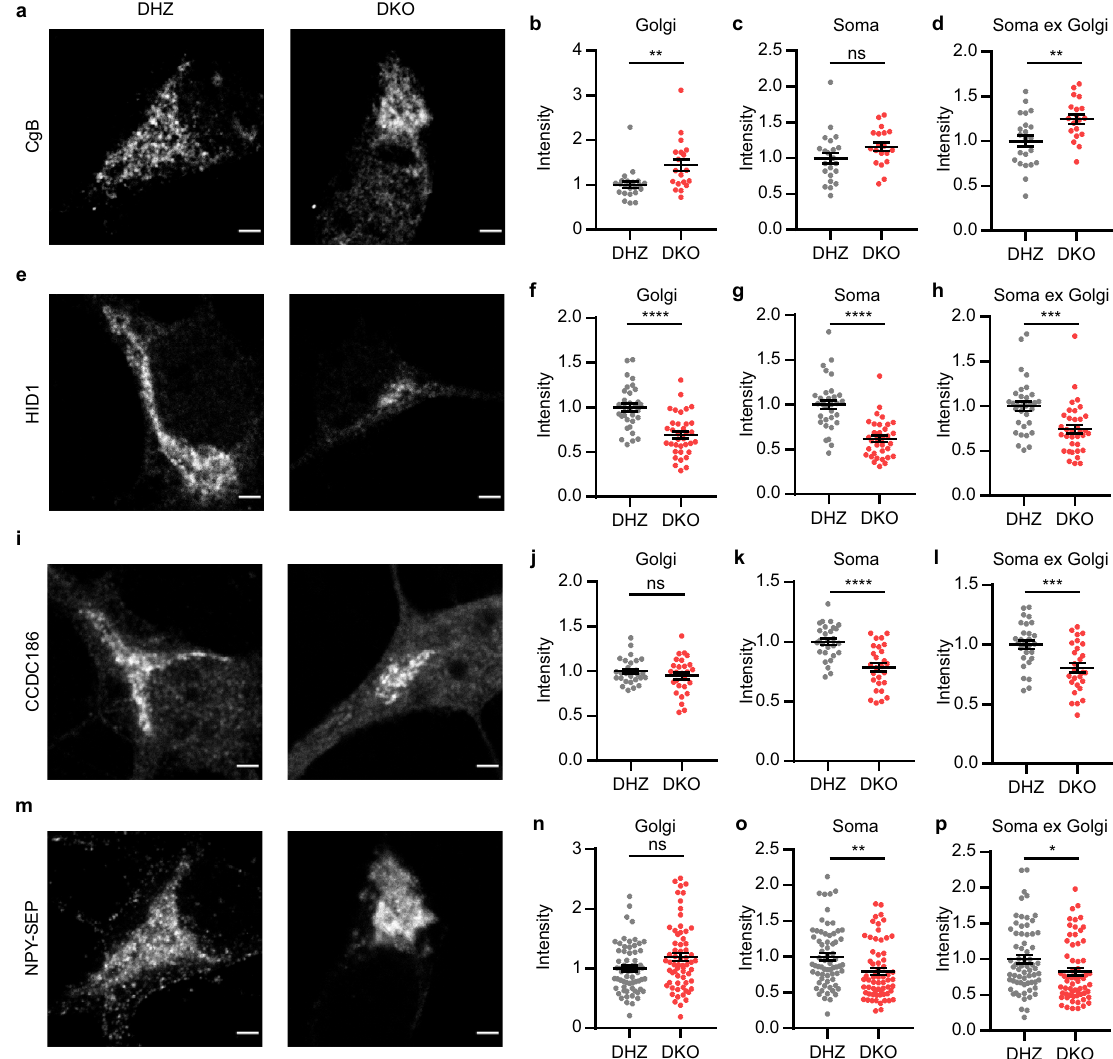
Figure 3. Levels and localization of DCV proteins are affected in Vti1a/b DKO neurons. ( a ) Representative examples of neurons immunostained for CgB. ( b – d ) CgB normalized staining intensity is increased in the Golgi (Mann Whitney test: **p = 0.0024) ( b ), not significantly different in the soma ( t -test: ns, p = 0.1142) ( c ), and increased in the soma excluding Golgi ( t -test: **p = 0.0056) ( d ) (DHZ: n = 22; DKO: n = 19). ( e ) Representative examples of neurons immunostained for HID1. ( f–h ) HID1 normalized staining intensity is decreased in the Golgi ( t -test: ****p < 0.0001) ( f ), soma (Mann Whitney test: ****p < 0.0001) ( g ), and soma excluding Golgi (Mann Whitney test: ***p = 0.0001) ( h ) (DHZ: n = 32; DKO: n = 35). ( i ) Representative examples of neurons immunostained for CCDC186. ( j – l ) CCDC186 normalized staining intensity is not significantly different in the Golgi ( t -test: ns, p = 0.2927) ( j ), but decreased in the soma ( t -test: ****p < 0.0001) ( k ), and soma excluding Golgi ( t -test: ***p = 0.0006) ( l ) (DHZ: n = 28; DKO: n = 27). ( m ) Representative examples of neurons expressing NPY- SEP. ( n – p ) NPY-SEP normalized fluorescence intensity is not significantly different in the Golgi (Mann Whitney test: ns, p = 0.0567) ( n ), but decreased in the soma (Mann Whitney test: **p = 0.0016) ( o ), and soma excluding Golgi (Mann Whitney test: *p = 0.0111) ( p ) (DHZ: n = 67; DKO: n = 64). Bars show mean ± SEM. Detailed statistics are shown in Supplementary Table 1. Scale bar is 2